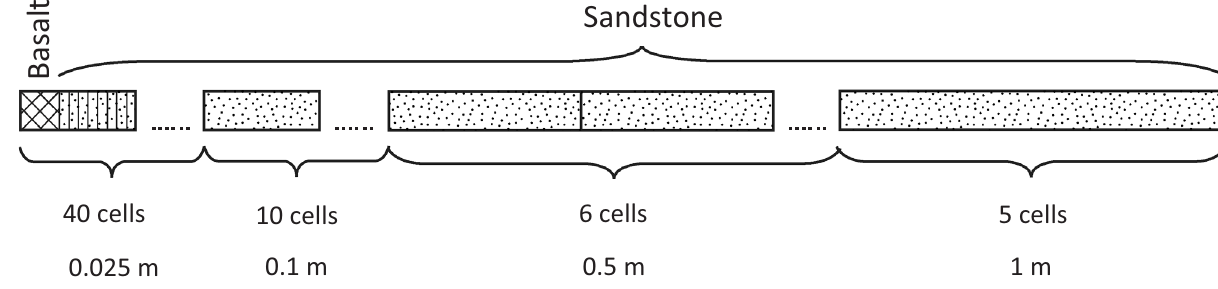
Figure 11. Conceptual representation of the 10-m 1D column modelled over a period of 5000 years with dissolution, precipitation and diffusion. The column was divided into 61 cells with the following size distribution from left to right: 40 cells of 0.025 m, 10 cells of 0.1 m, 6 cells of 0.5 m and 5 cells of 1 m. The first cell contained basalt of tholeiitic composition in scenario 2 and 3 while the remaining cells contain detrital minerals according to Table 1. In scenario 1 all cells contained detrital minerals as presented in Table